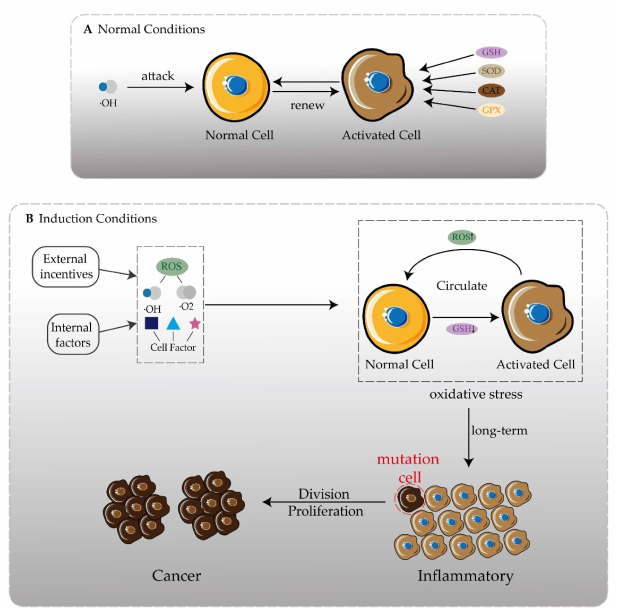
Figure 1. One of the inducements of disease development is oxidation. ( A ) Under normal circum- stances, free radicals attacking normal cells activates the secretion of antioxidant enzymes and still maintains redox balance. ( B ) In the presence of internal and external inducements, more free radicals and cytokines appear. The oxidative balance in the body cannot be maintained, forming an oxidative stress state, and inflammation may occur. There is always an oxidative stress state in the body, and the possibility of chronic inflammation gradually developing into cancer is greatly